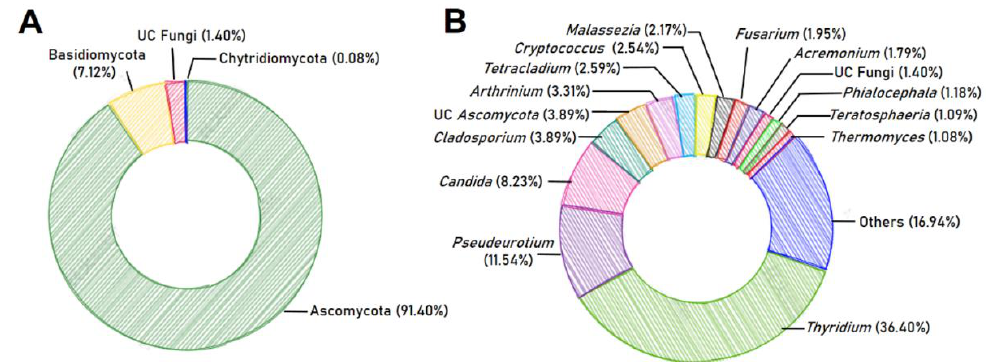
Figure 1. Taxonomic composition of the whole fungal microbiome coexisting with Karlodinium veneficum at ( A ) phylum and ( B ) genus levels. Pie charts represent the relative abundance of phyla/genera for the entire fungal community. UC: unclassified.